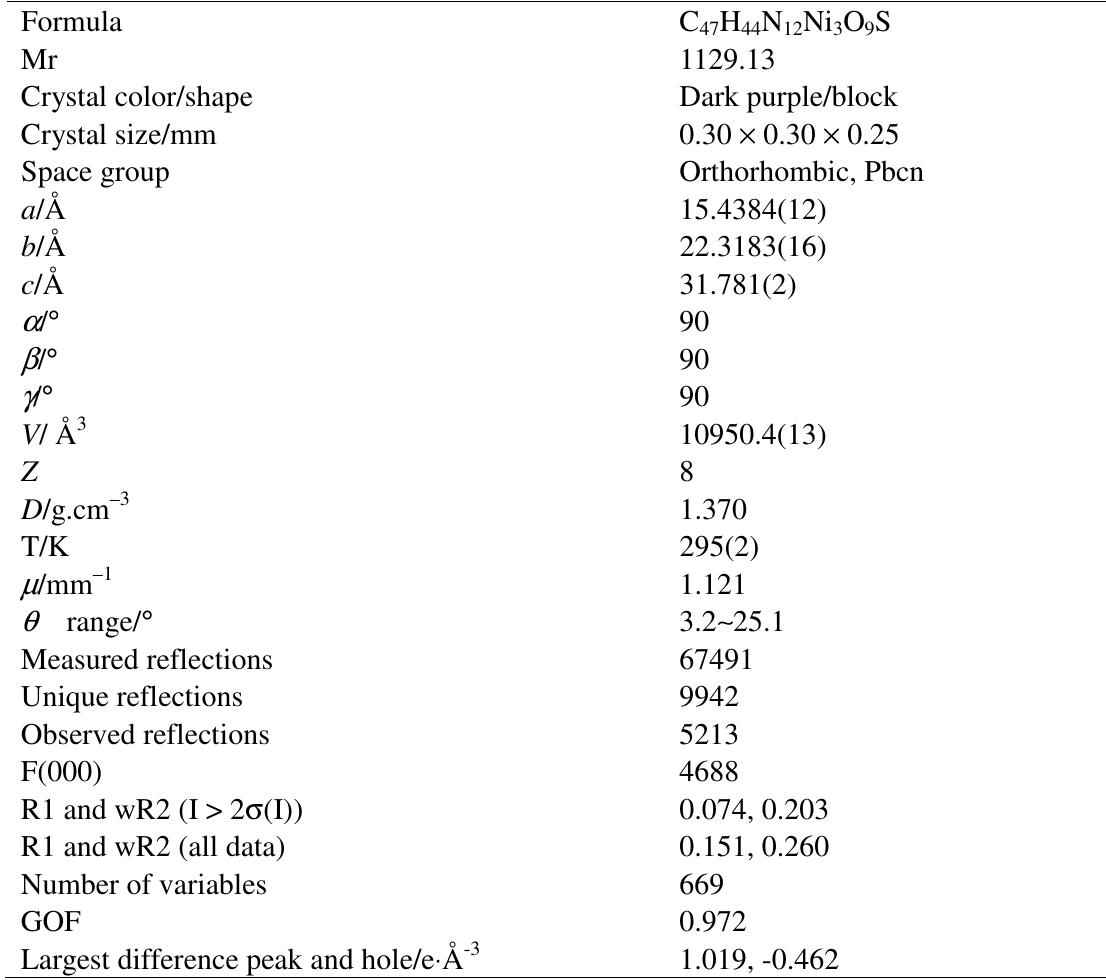
Table 2. Crystallographic data and refinement parameters for complex 1